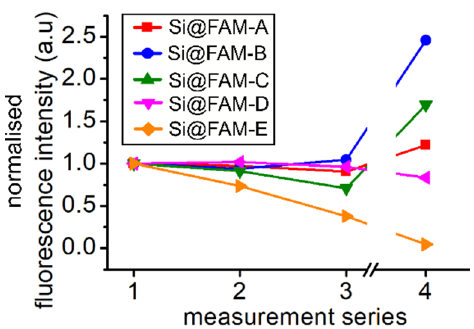
Figure 3. Sensor photostability at different bead loadings observed as changes in the fluorescent intensity over repeated measurements. All measurements were taken at pH 7.2.